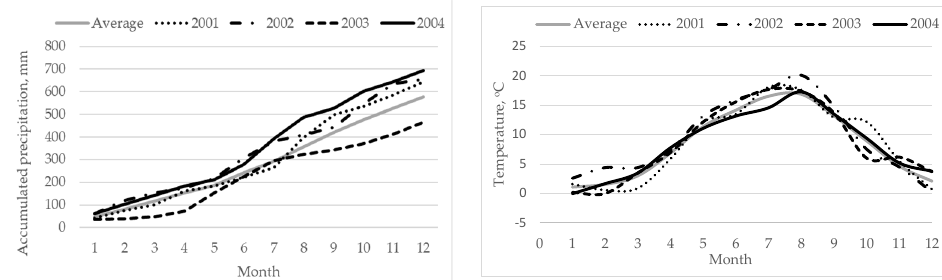
Figure 1. Accumulated precipitation in 2001, 2002, 2003, 2004 and as an average from 1987 to 2004 (left). The monthly average temperature in 2001, 2002, 2003, 2004 and as an average from 1987 to 2004 (right).